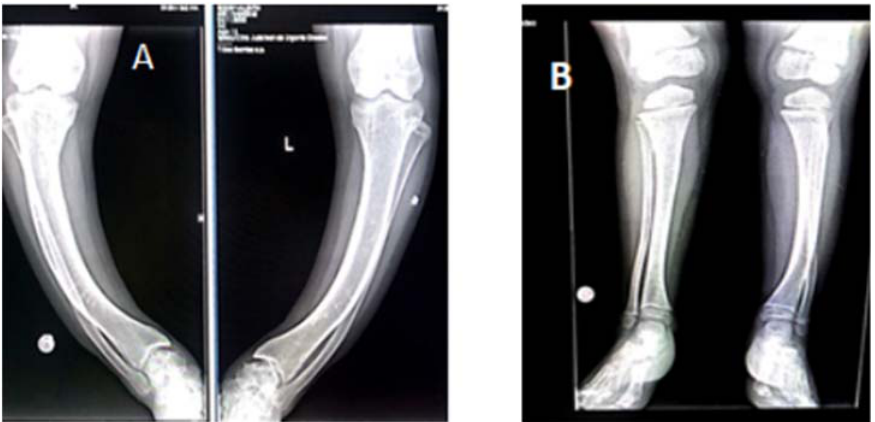
Figure 4. Tibial and fibular radiography (April 2022). ( A ): Case #1: tibial scoliostosis, mild bilateral fibular deformation, closed growth plates. ( B ): Case #2: left tibia: scoliostosis in varum, right tibia: